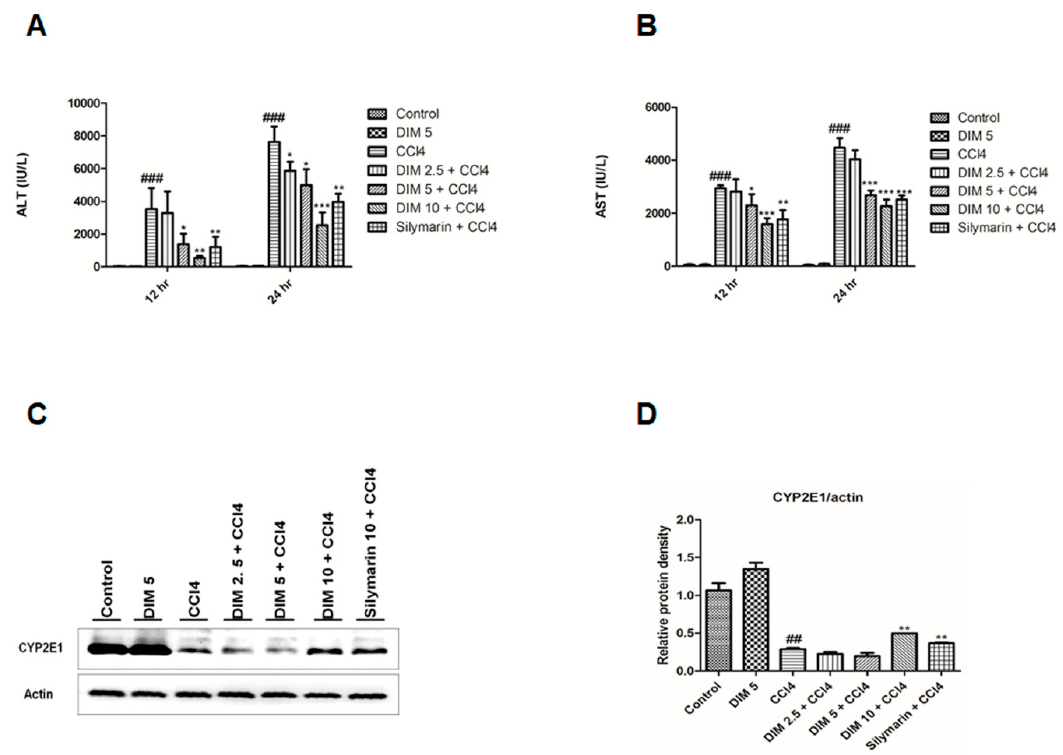
Figure 1. Effects of 3,3 ′ -diindolylmethane (DIM) on serum levels of alanine aminotransferase (ALT, A ) and aspartate aminotransferase (AST, B ) at 12 and 24 h after CCl 4 administration. Data are expressed as mean ± SD ( n = 5). ( C ) Immunoblot analysis of Cytochrome P450 2E1 (CYP2E1) at 24 h after CCl 4 injection. ( D ) Quantification of relative protein expression normalized to β -actin. Data are expressed as mean ± SD ( n = 3). ### p < 0.001 and ## p < 0.01 denotes significant differences compared to the normal control group, * p < 0.05, ** p < 0.01, *** p < 0.001 compared to the CCl 4 group.